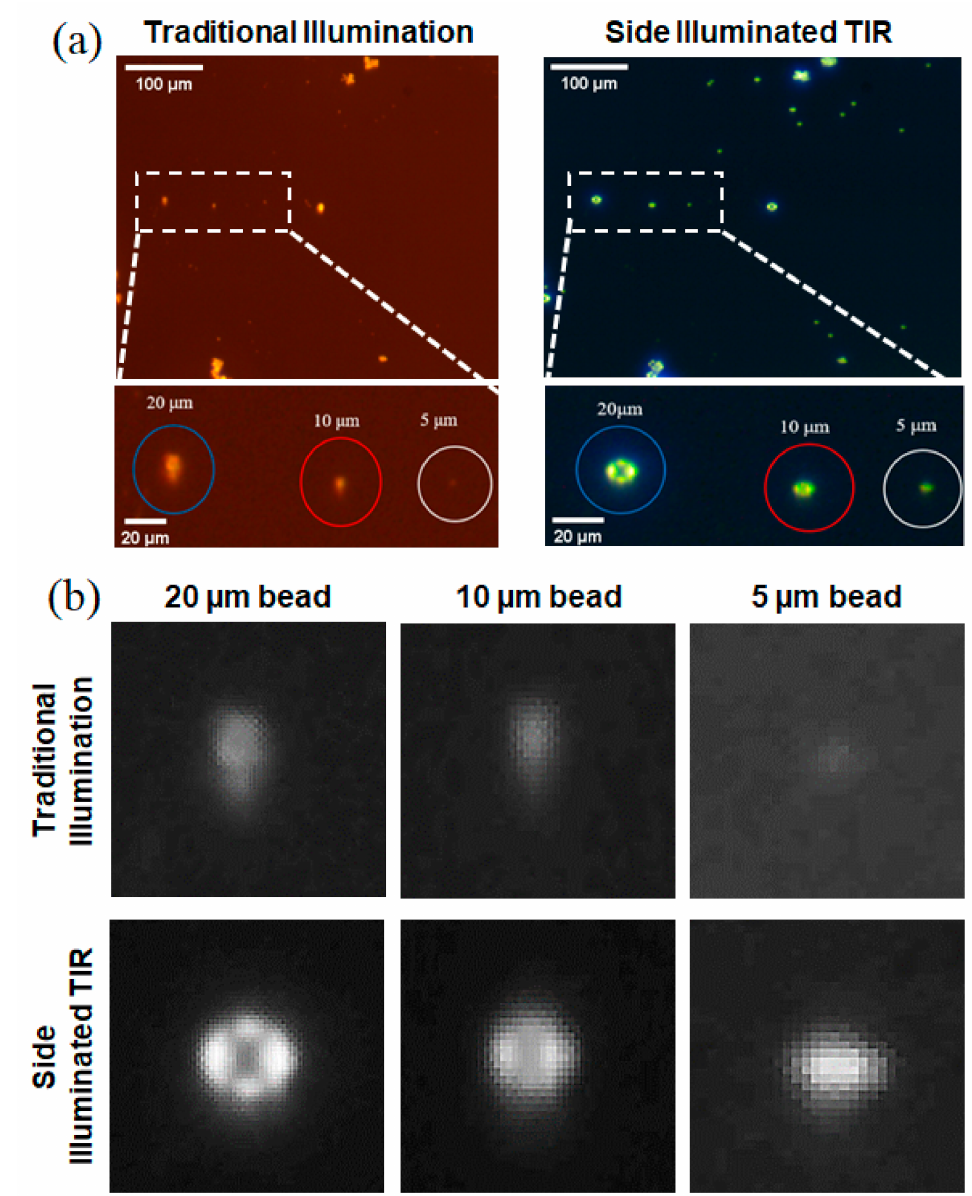
Figure 3. Images of polystyrene beads acquired using an LDM with two different illumination methods. Transmission illumination is blurrier and shows a smaller number of polystyrene beads when compared to side-illuminated TIR. ( a ) Raw images and ( b ) digitally zoomed images from each